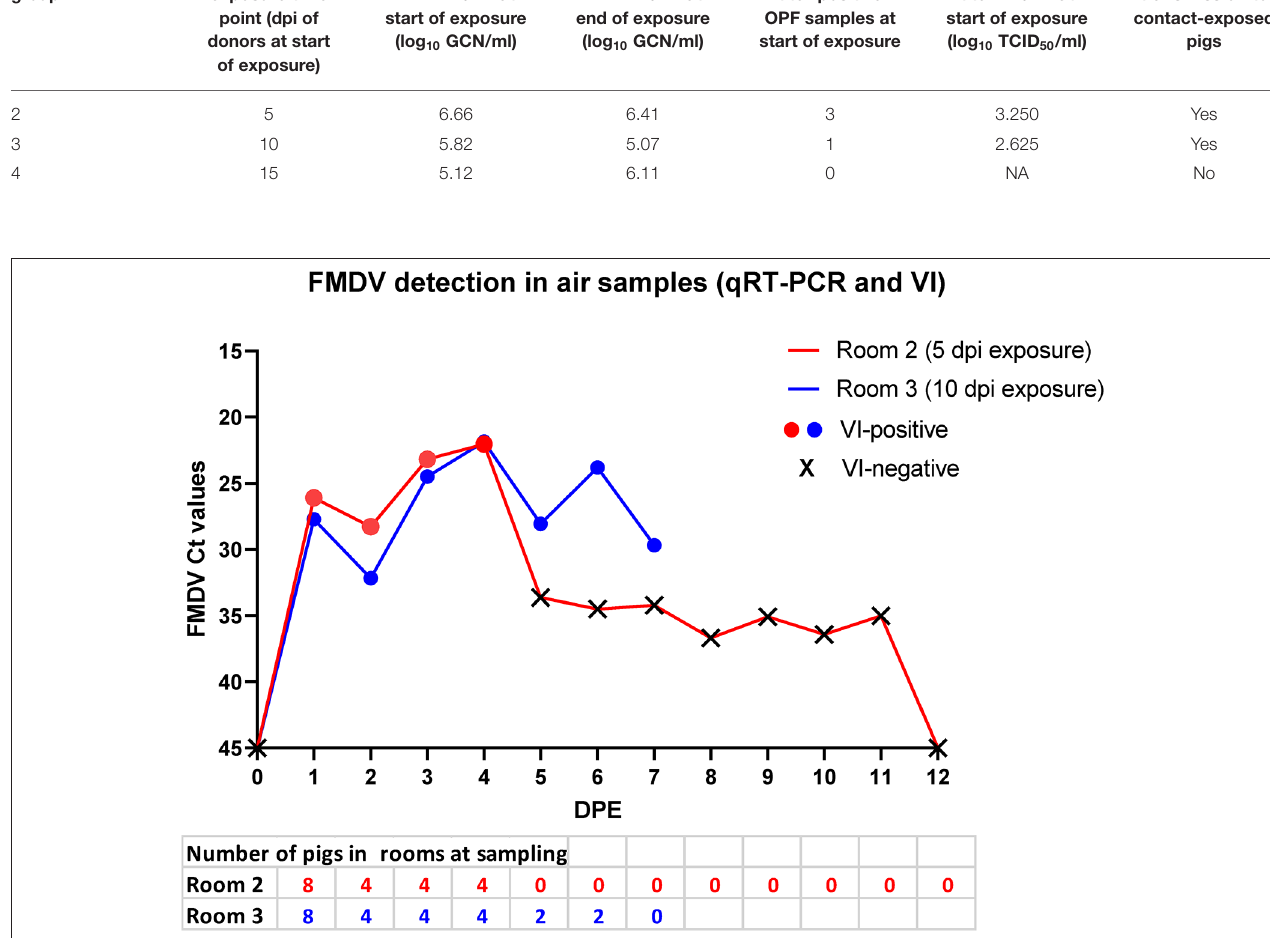
FIGURE 2 | FMDV detection in air samples. FMDV RNA quantities and isolation of infectious FMDV from dry air filters collected from isolation rooms housing pigs that were exposed to FMDV-infected donor pigs for 24h at 5 (red) or 10 (blue) days post infection of the donors. The Y-axis represents FMDV RNA quantities (Ct values) determined by qRT-PCR. Colored symbols indicate samples from which infectious virus was isolated, while X indicate virus isolation-negative samples. The donor pigs were in the sampled rooms from 0 to 1 days post exposure (dpe). The 4 contact-exposed pigs in group 2 (red) were euthanized and removed at 4 dpe. Two of 4 pigs in room 3 (blue) were euthanized at 4 dpe, and the remaining 2 pigs at 6 dpe. Air sampling continued for 1 or 8 days after removal of the last pig from the